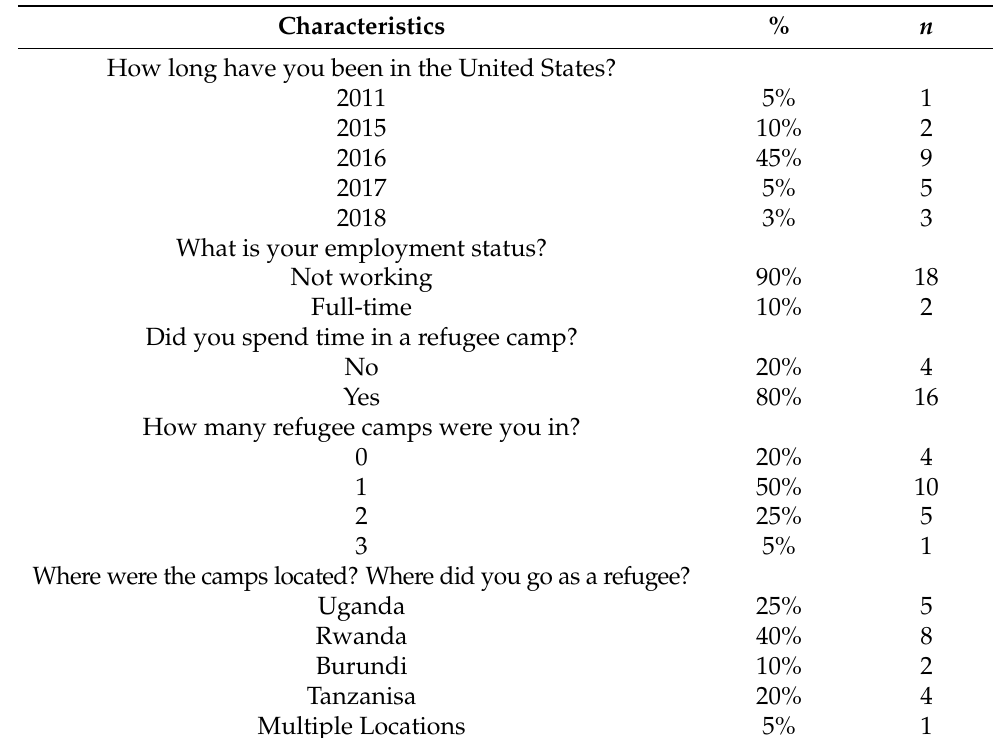
Table 1. Demographic characteristics of participants ( n =